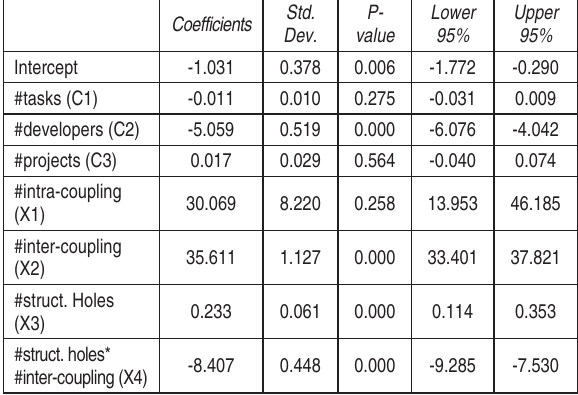
Table 5. Number of new projects